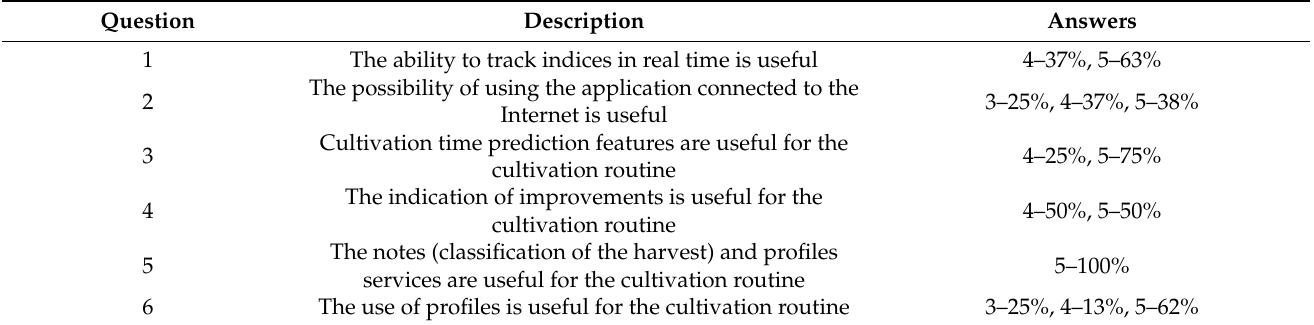
Table 6. Items related to assessment of the perceived utility of